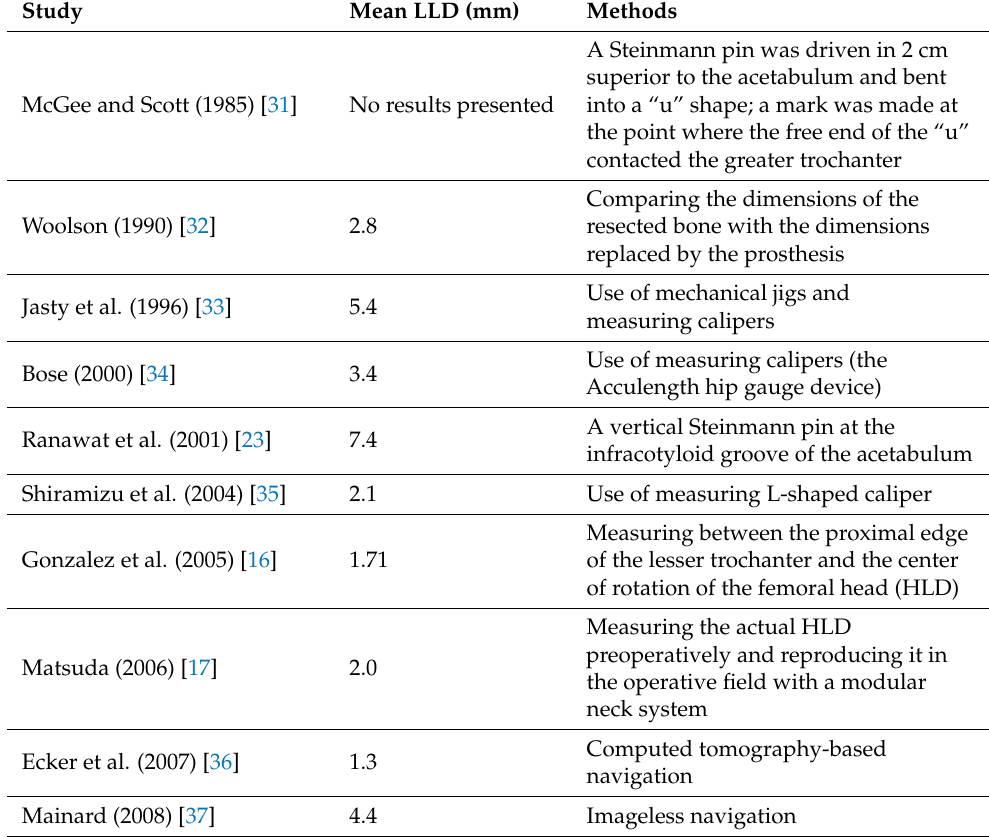
Review of the literature reported by many authors with various results with intraoperative